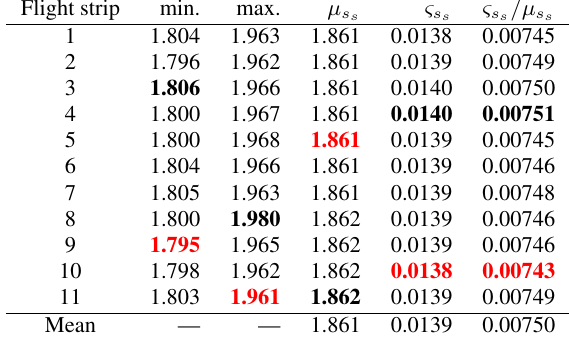
Table 3: Statistics for the system waveform amplitudes ˆ S of the 2005 campaign (unit: DN). Bold figures denote the minima and maxima per category for the whole campaign,